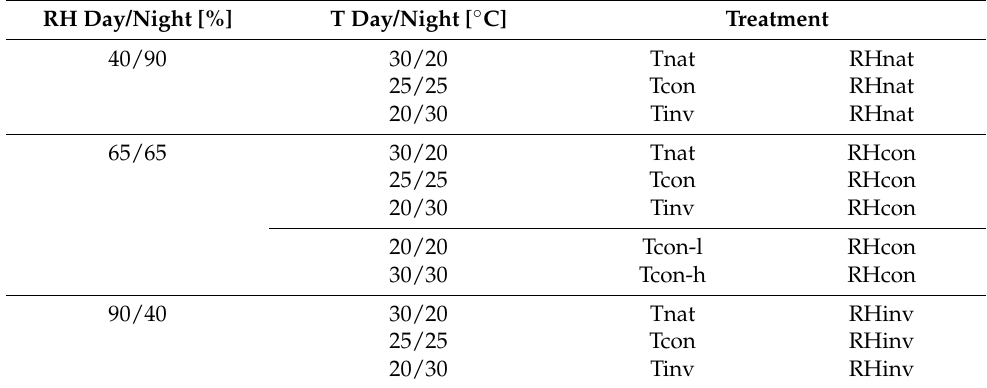
Table 1. Cultivation conditions for rice plants starting 35 days after sowing until 49 days after sowing [20]. RH Day/Night [%]